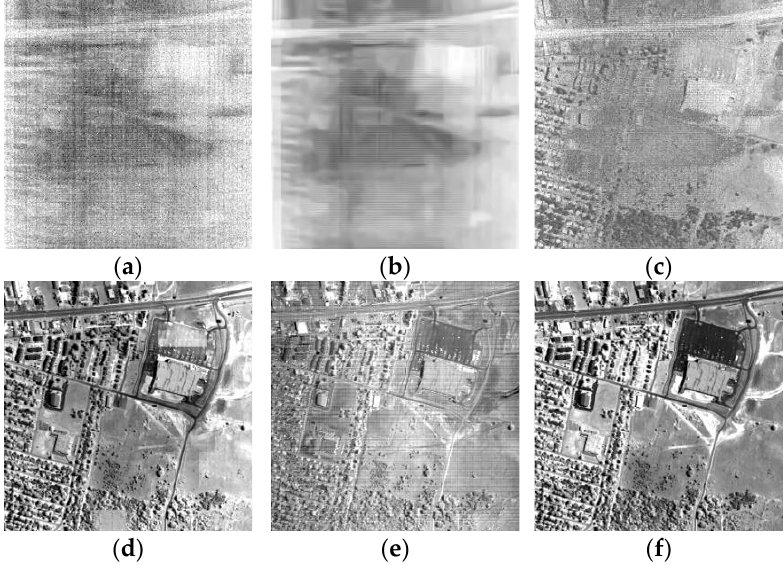
Figure 7. Inpainting results of band 105 of Urban dataset. ( a ) Original image; ( b ) PDE; ( c ) UBD; ( d ) LLRSSTV; ( e ) BPFA; and ( f ) INORSDL.